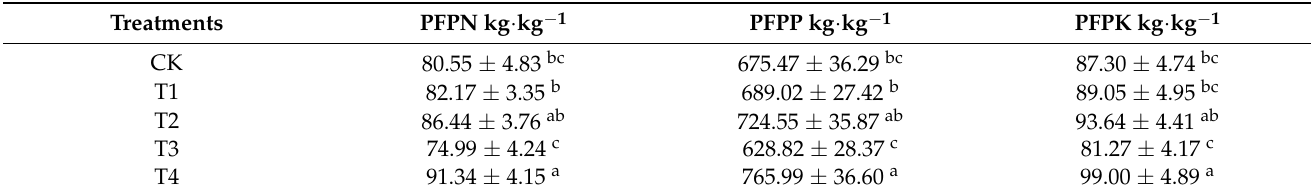
Table 4. The partial factor productivity of different fertilizers on cherry tomato grown with different dynamic concentrations of nutrient solution (PFFN, partial factor productivity from applied nitrogen; PFFP, partial factor productivity from applied phosphorus; PFFK, partial factor productivity from applied